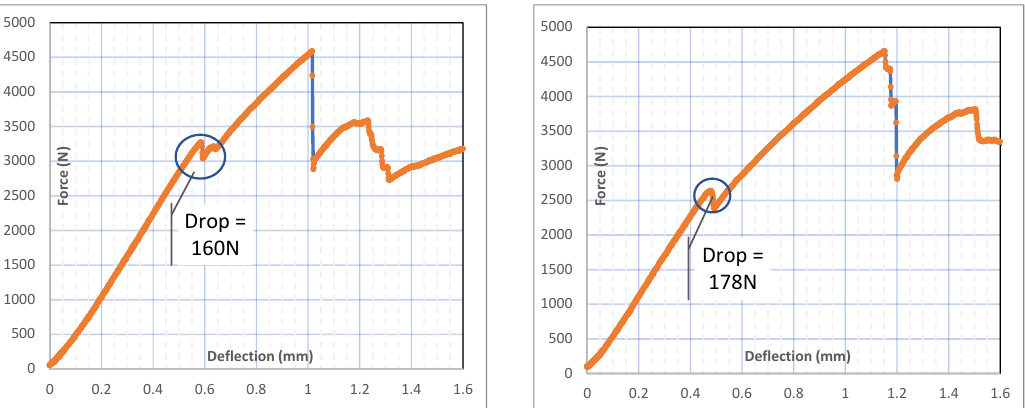
Figure 8. Force – deflection (3-point test); samples were exposed to conditions of T = 20 °C and H = 40% for three days.